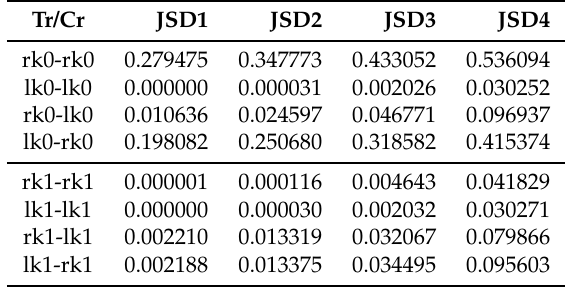
Table 3. JSD between training data and cracking target data in Table 2.